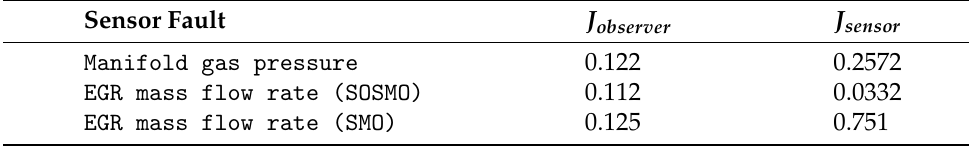
Table 2. Quantitative performance